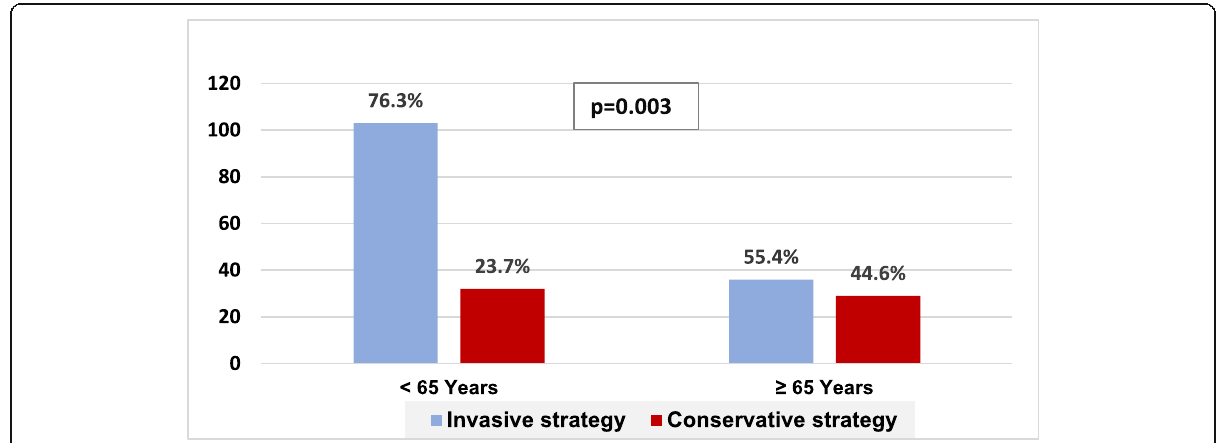
Fig. 1 Management strategy in NSTE-ACS according to age